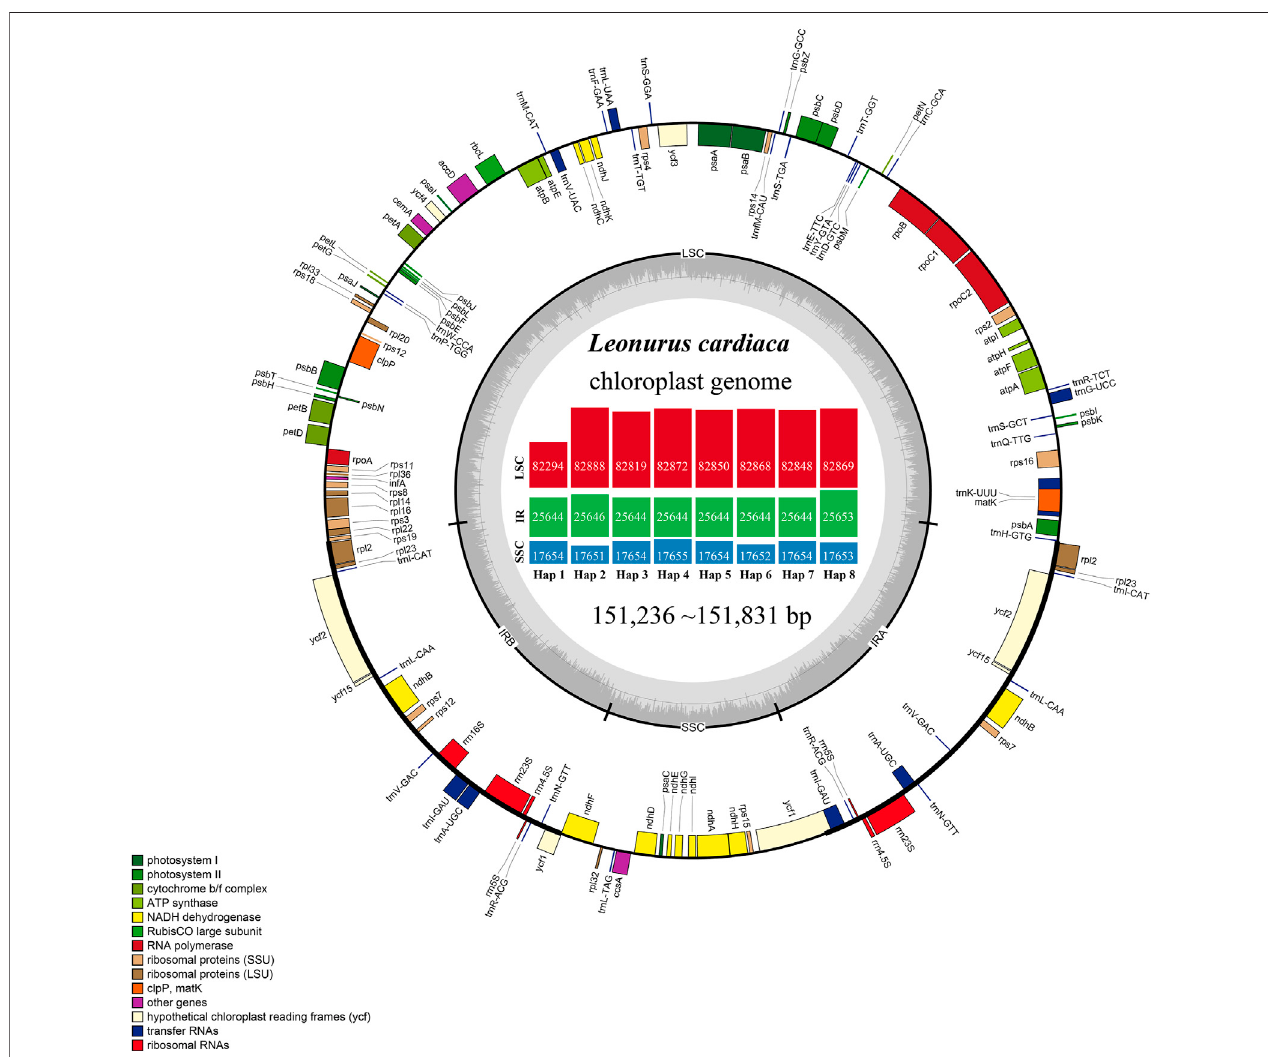
FIGURE 1 | Gene maps of the chloroplast genomes of L. cardiaca . Genes on the inside of the large circle are transcribed clockwise and those on the outside are transcribed counter clockwise. The genes are color-coded based on their functions. The dashed area represents the GC composition of the chloroplast genome. The histogram inside represents different parts size of eight